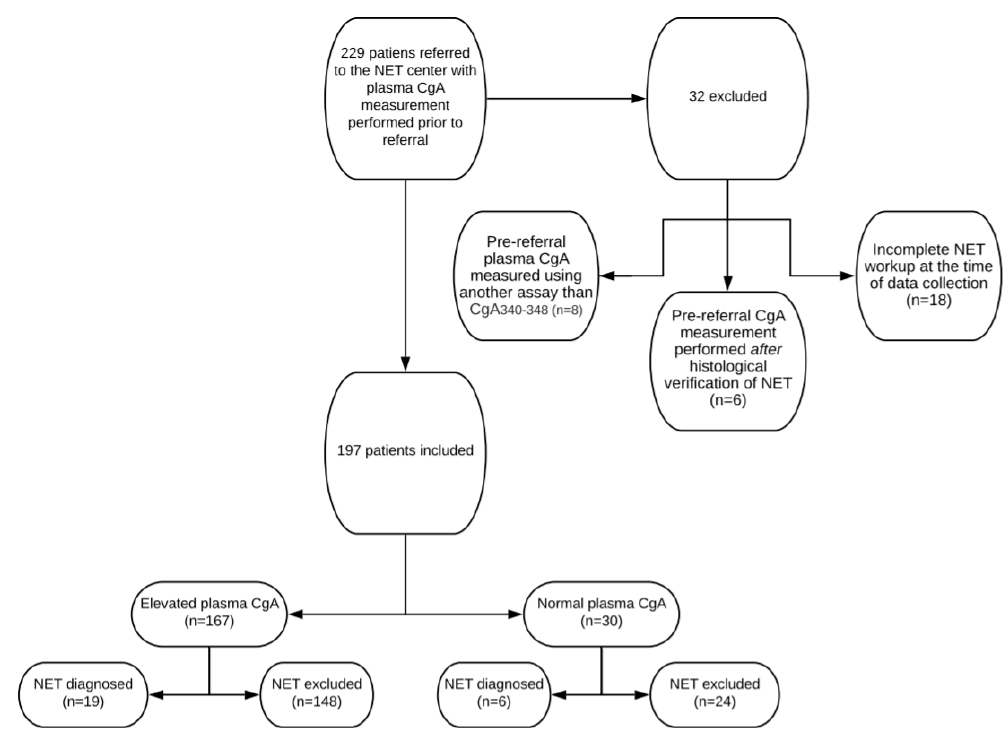
Figure 2. Flowchart of included and excluded patients, pre-referral CgA plasma concentration levels and total number of neuroendocrine tumors diagnosed.